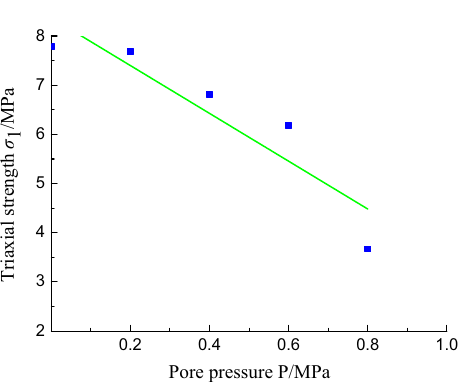
Figure 12. The fitting curve of the triaxial strength versus the pore